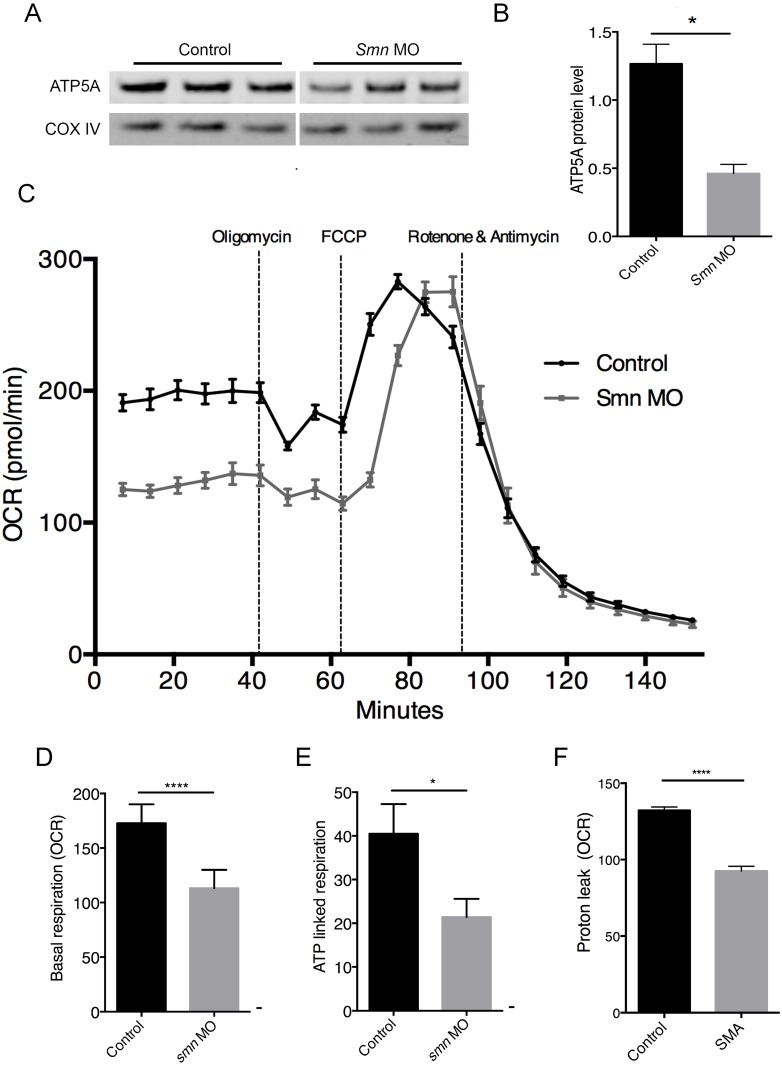
Mitochondrial dysfunction occurs in smn morphant zebrafish.(A) Levels of ATP5A protein, a subunit of mitochondrial membrane ATP synthase, were significantly reduced in smn morphant zebrafish. (B) Levels were quantified using fluorescent Western blotting and normalized to COXIV loading control (N = 3 per group, batches of 30 pooled zebrafish embryos per lane). (C) Mitochondrial oxygen consumption rates (OCR) of control and smn morphant 24 hpf zebrafish analyzed using the Seahorse XF24 analyser showed mitochondrial bioenergetic defects (D) Basal respiration was significantly reduced in smn morphants compared to controls. (E) ATP linked respiration was significantly reduced in smn morphants compared to controls. (F) Mitochondrial proton leak was also reduced in smn morphants compared to controls. N = 14 per group) Unpaired two-tailed student t-test * P<0.05, ** p<0.01 *** p<0.001.